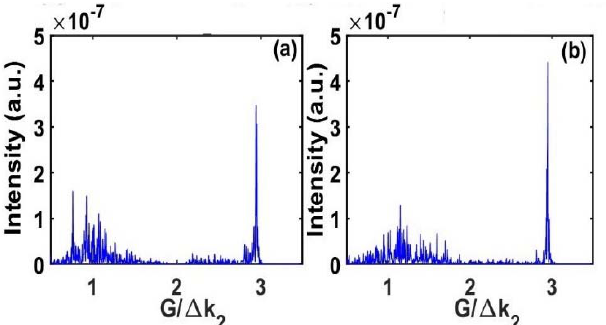
Figure 9. The Fourier transforms of the δ (z) functions of the designed nonlinear lattices. ( a , b ) refer to the APP − LN crystal for ( a ) different (Figure 4) or ( b ) equal (Figure 5) domain sizes in each segment.